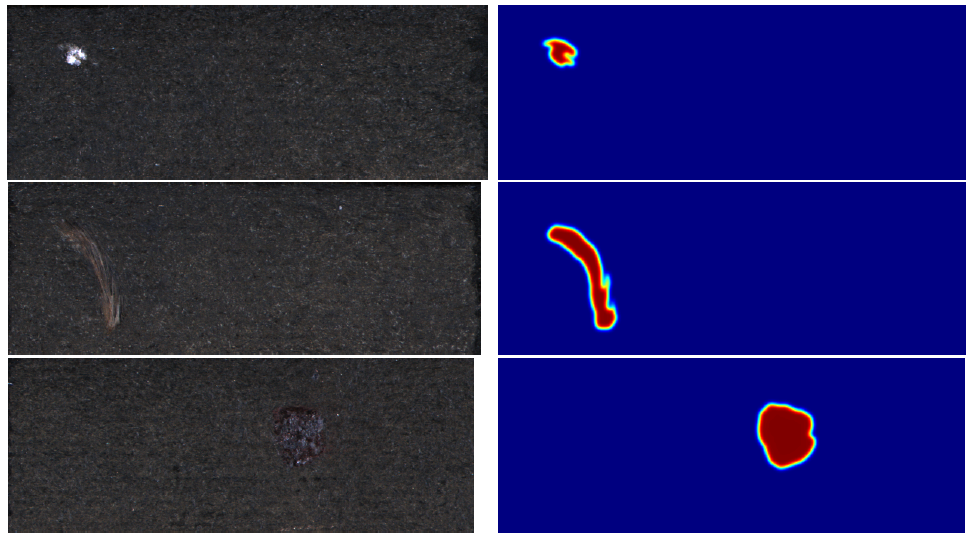
Figure 8. KolektorSDD2 test examples semantic segmentation result of U-Net trained with the balanced loss.